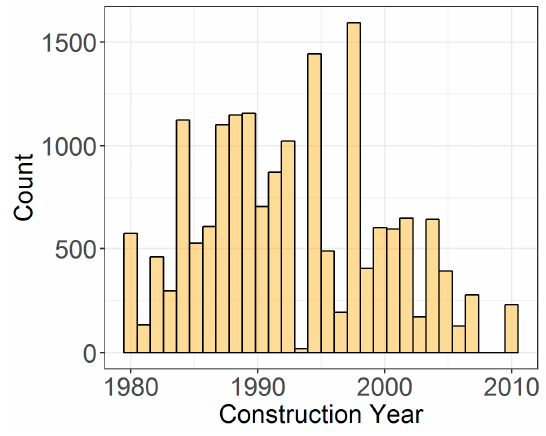
Figure 7. Construction year of panels in East Japan.